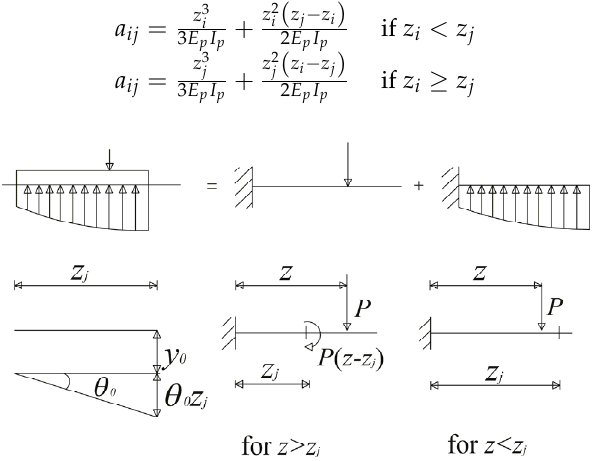
Figure 2. Pile flexibility matrix using the elastic beam theory (auxiliary restraint approach).